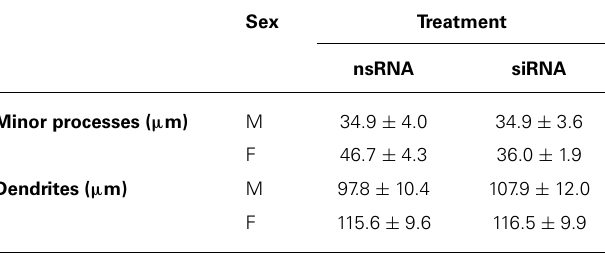
Table 2 | Length of minor processes and length of dendrites in male (M) and female (F) hypothalamic neuronal cultures transfected with